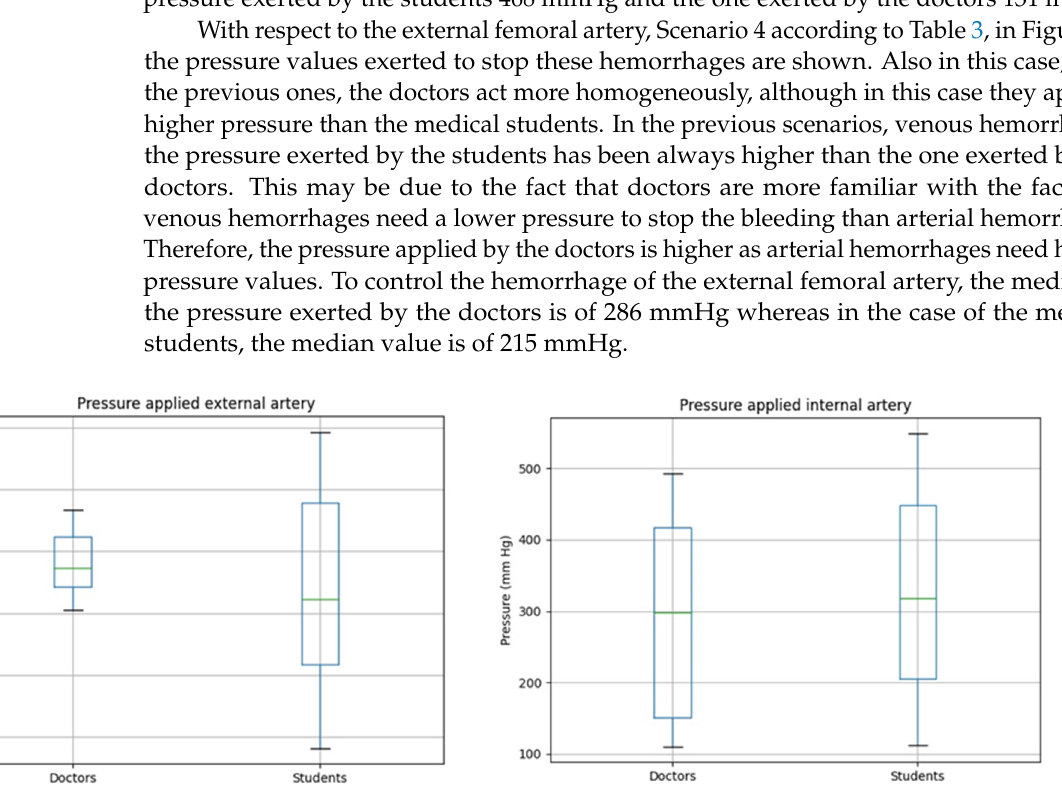
Figure 4. Pressure exerted to stop the bleeding by medical students and doctors if a venous bleeding occurs in the lower limb. ( a ) Pressure exerted to stop an external venous hemorrhage; ( b ) Pressure exerted to stop an internal venous hemor- rhage.